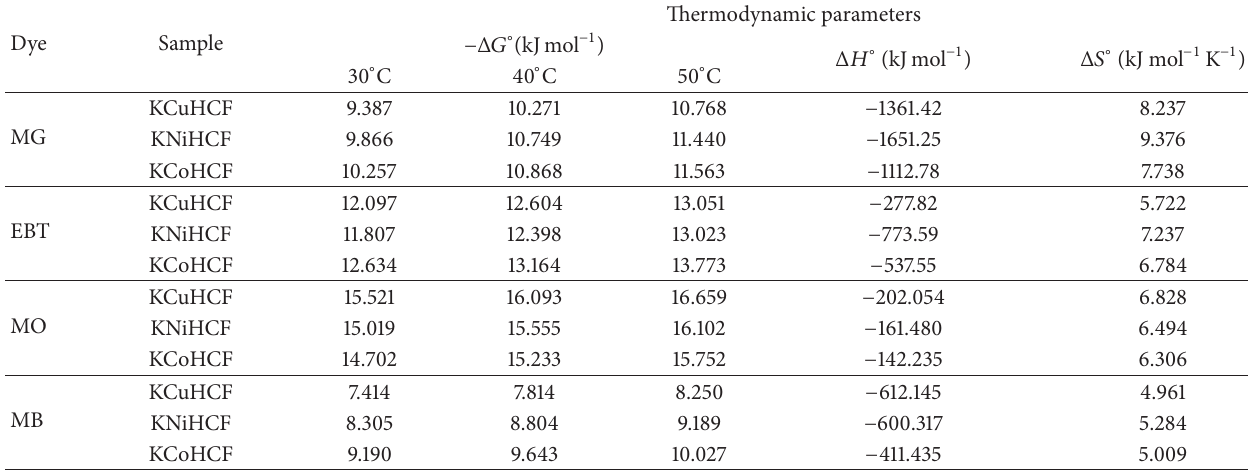
Table 4: Thermodynamic parameters of different dyes adsorption on various KMHCF nanoparticles. Dye